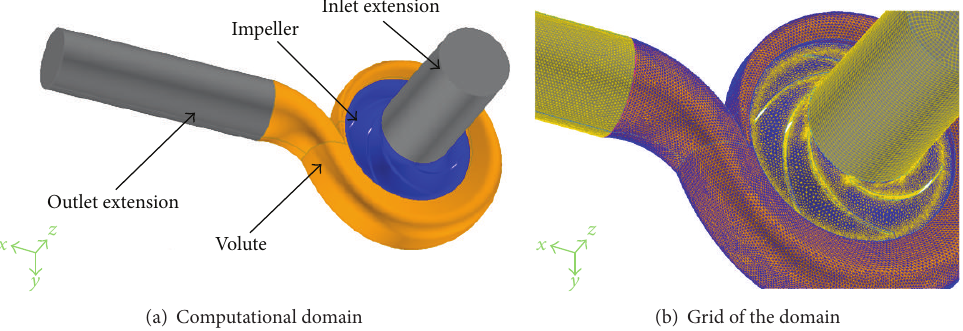
Figure 9: Computational domain and